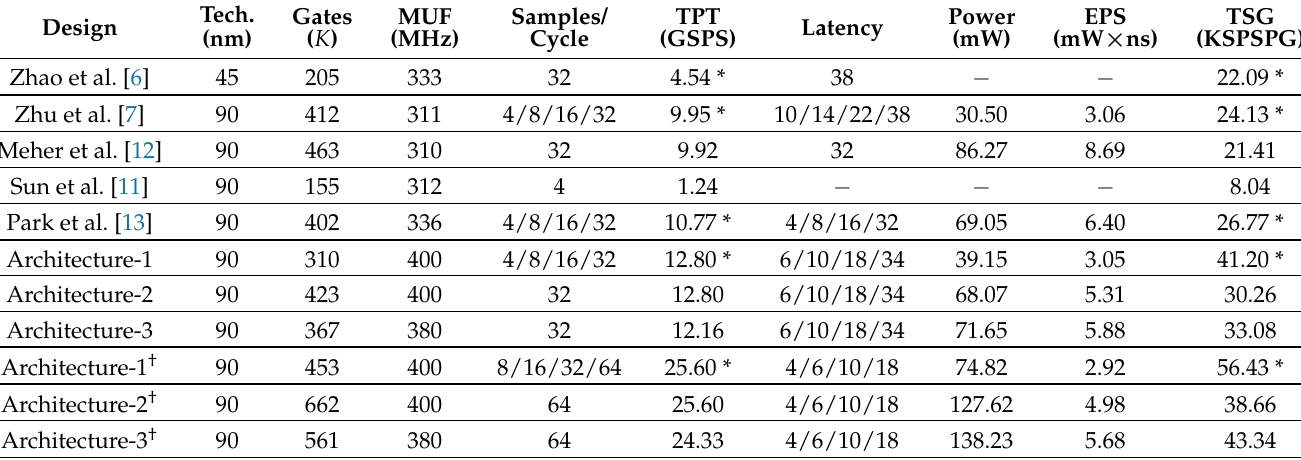
Table 3. Comparison of different 2D integer DCT